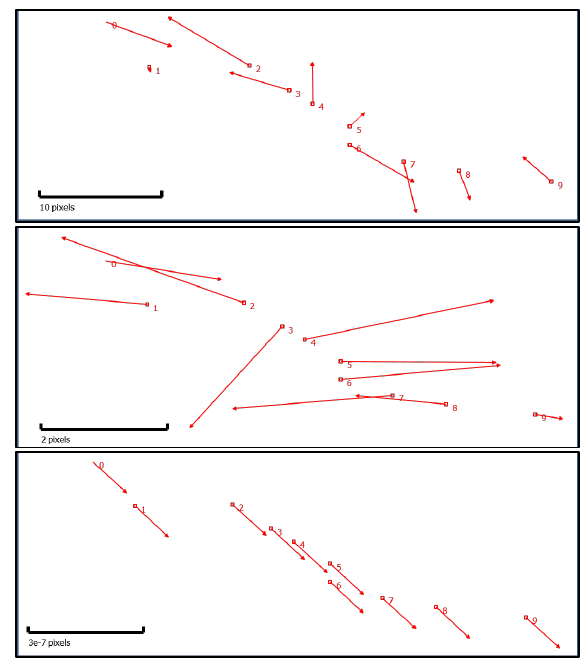
Figure 7: Residual plot for the transformation of the historical map using a similarity transformation (top), projective transformation (middle) and Thin Plate Spline (TPS) transformation (bottom). 1 pixel is approximately 1m.